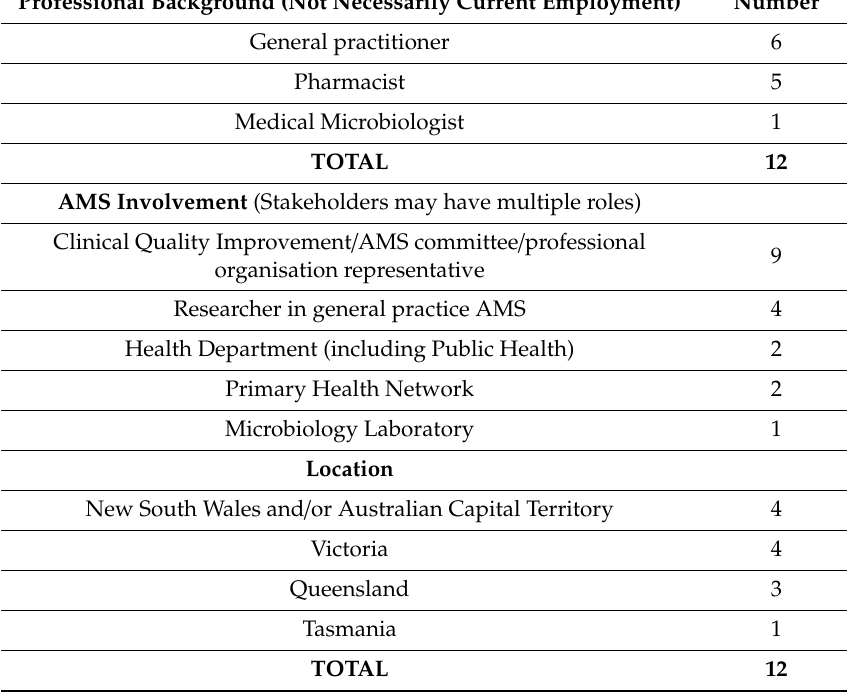
Table 1. The professional background, antimicrobial stewardship (AMS) involvement, and location of the 12 interviewed